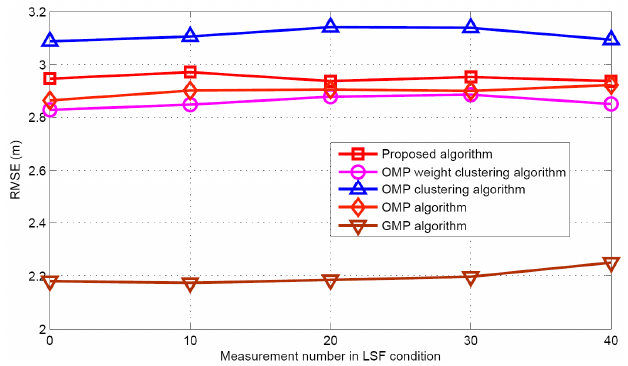
Figure 19. RMSE comparison in LSF conditions.